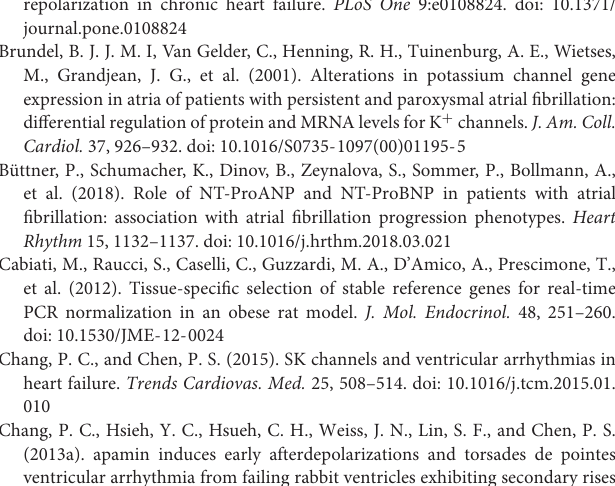
Supplementary Figure 1 | Flow chart illustrating the inclusion criteria. Number (N ◦ ) of human heart tissue samples entered, removed after assessment at different quality control stages, and finally included in the analyses is shown. PCA, Principal component analysis; TPM, transcripts per kilobase million. Supplementary Figure 2 | mRNA expression of housekeeping genes in transcripts per kilobase million (TPM) assessed by RNA-seq. (A) GAPDH (glyceraldehyde-3-phosphate dehydrogenase), (B) PPIA (peptidylprolyl-isomerase A), and (C) HPRT1 (hypoxanthine-phosphoribosyltransferase 1). Sample provenance: left ventricle (LV; • , right atrial appendage (RAA; (cid:78) ), left atrium (LA; (cid:72) ). Patient’s health status: non-diseased (ND; green, open symbols); heart failure (HF): pooled data from dilated cardiomyopathy (DCM; light blue) and ischemic cardiomyopathy (ICM; blue); sinus rhythm (SR): pooled data from coronary artery disease (CAD; ocher) and heart valve disease (HVD; orange); atrial fibrillation (AF; red). The mean ± SD data are represented. Statistical significance was assessed by Dunn’s test. For HF and SR, statistical significance was assessed by the Mann–Whitney